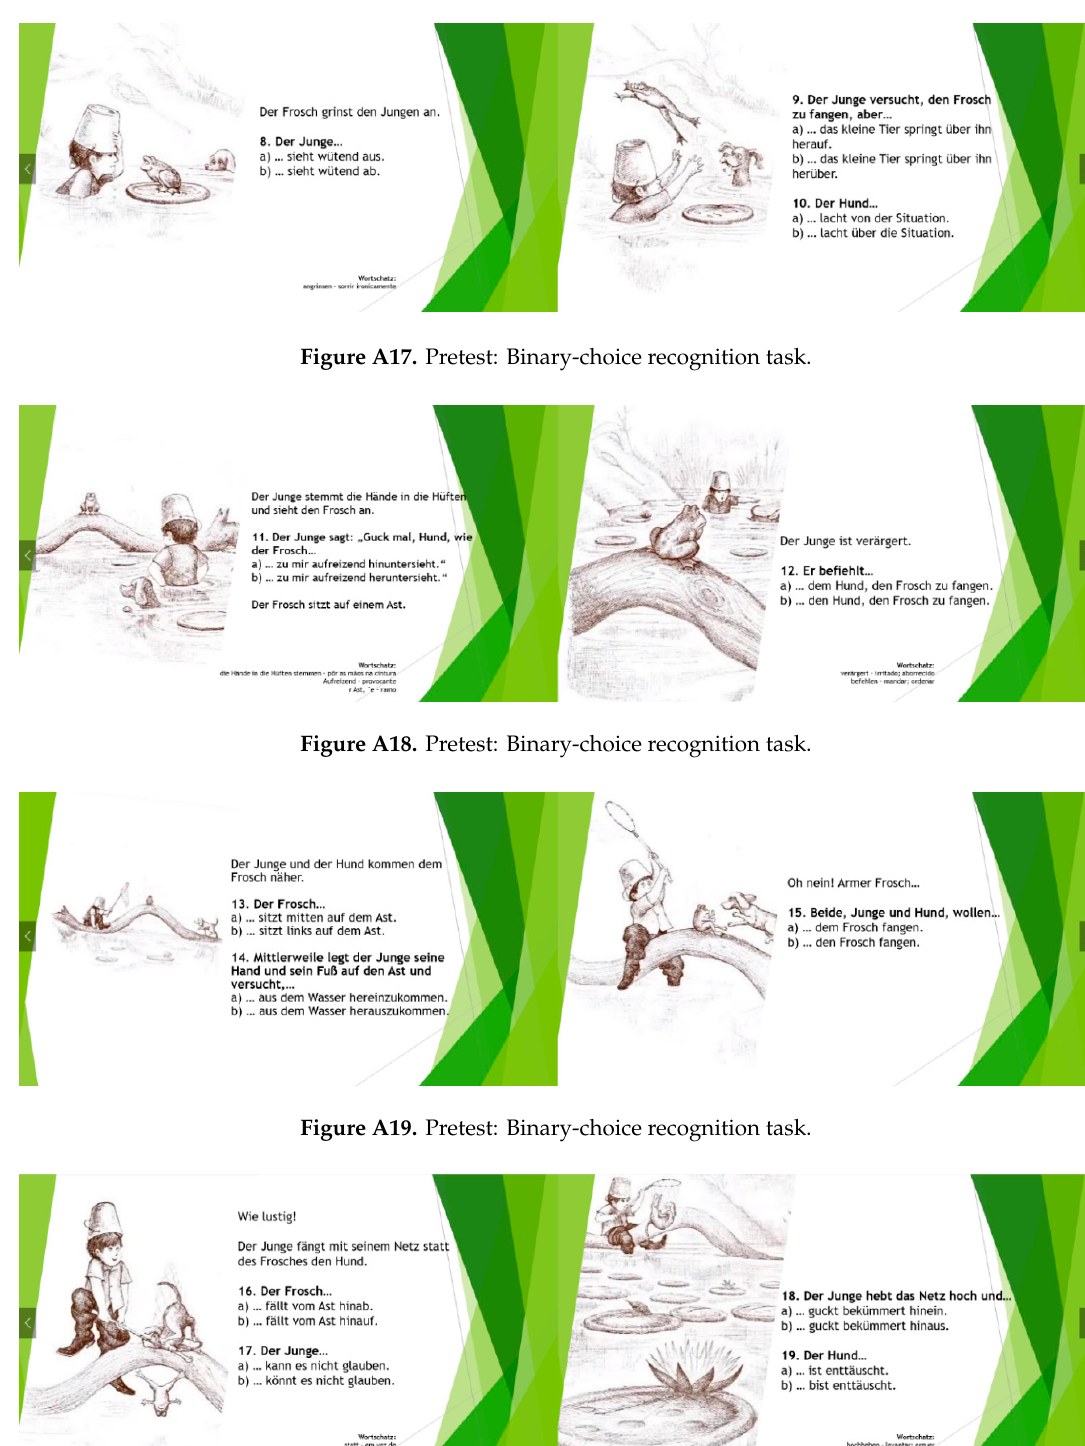
Figure A20. Pretest: Binary-choice recognition task.